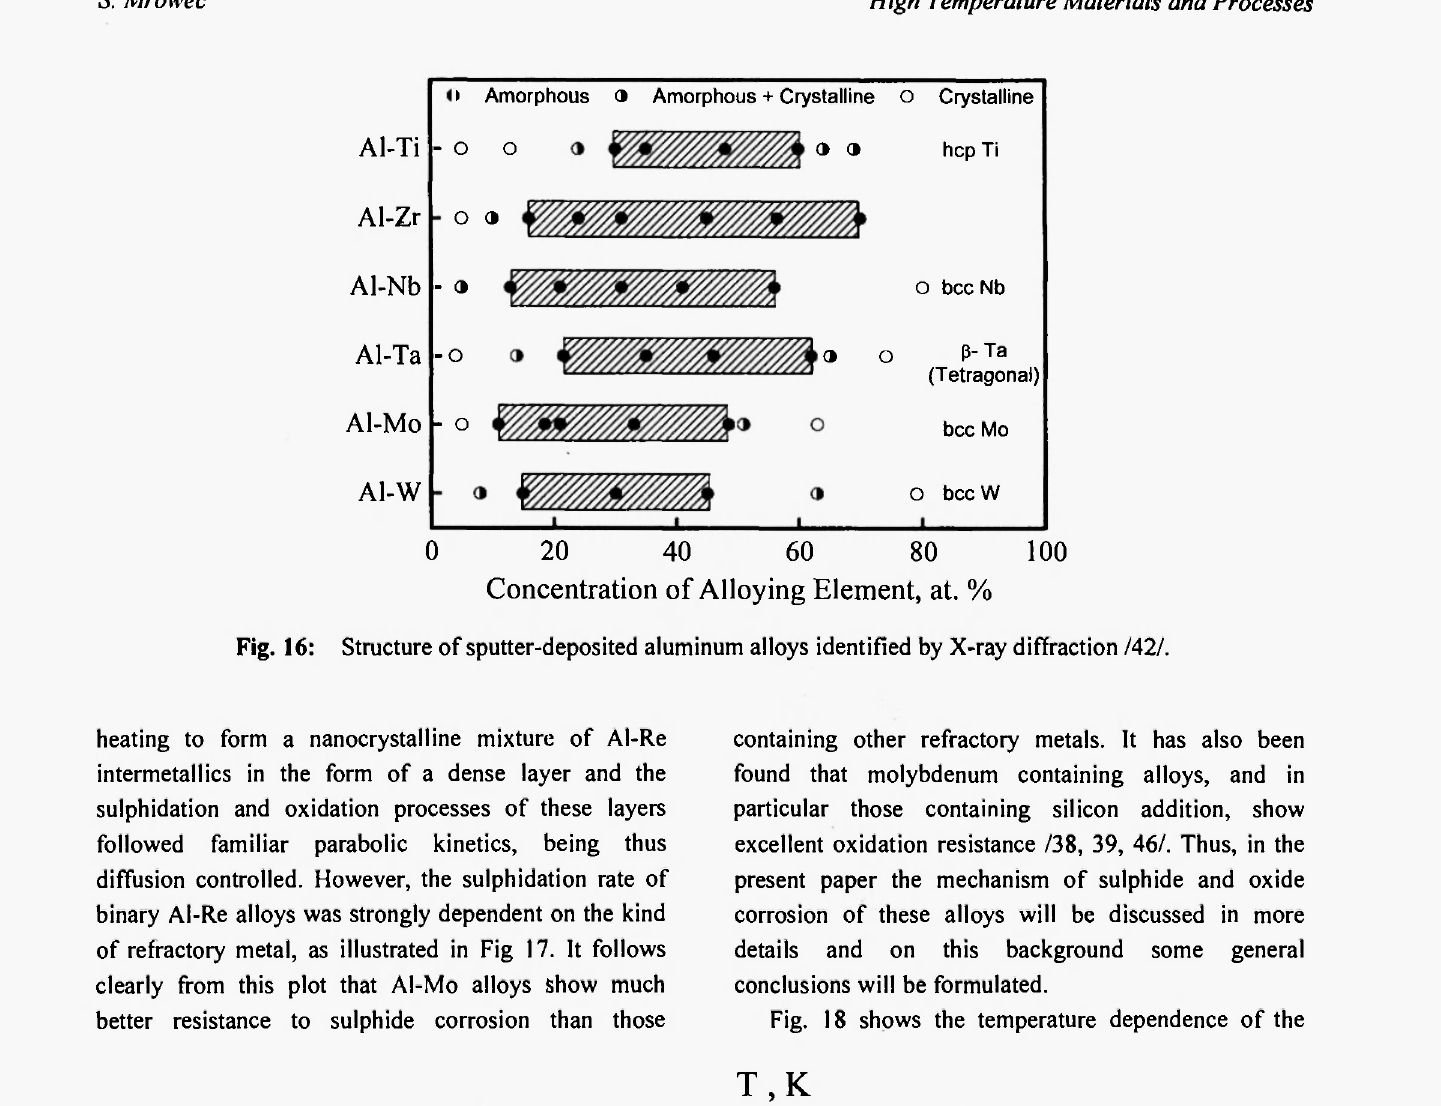
Fig. 17: Temperature dependence of the sulphidation rates of binary Al-Mo, Al-Nb and Al-Ta